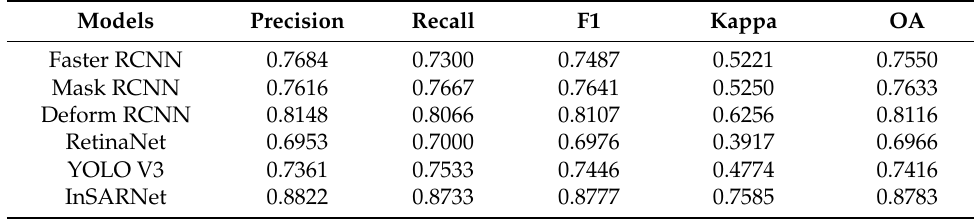
Table 10. Comparison of the different detection models in test area C.